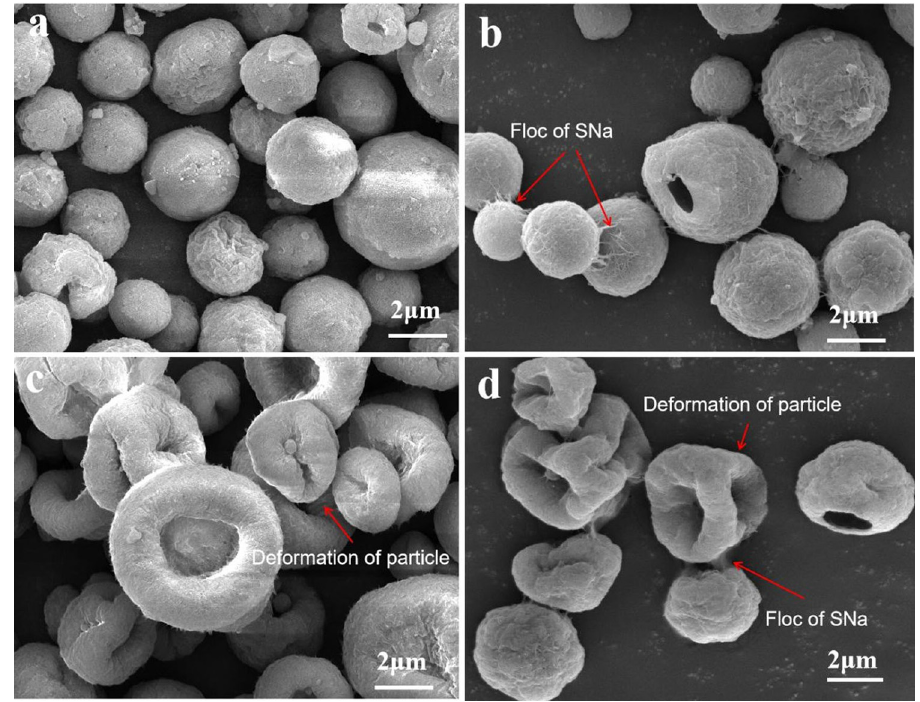
Figure 3: SEM pictures of ( a ) S0, ( b ) S1, ( c ) S2, and ( d )